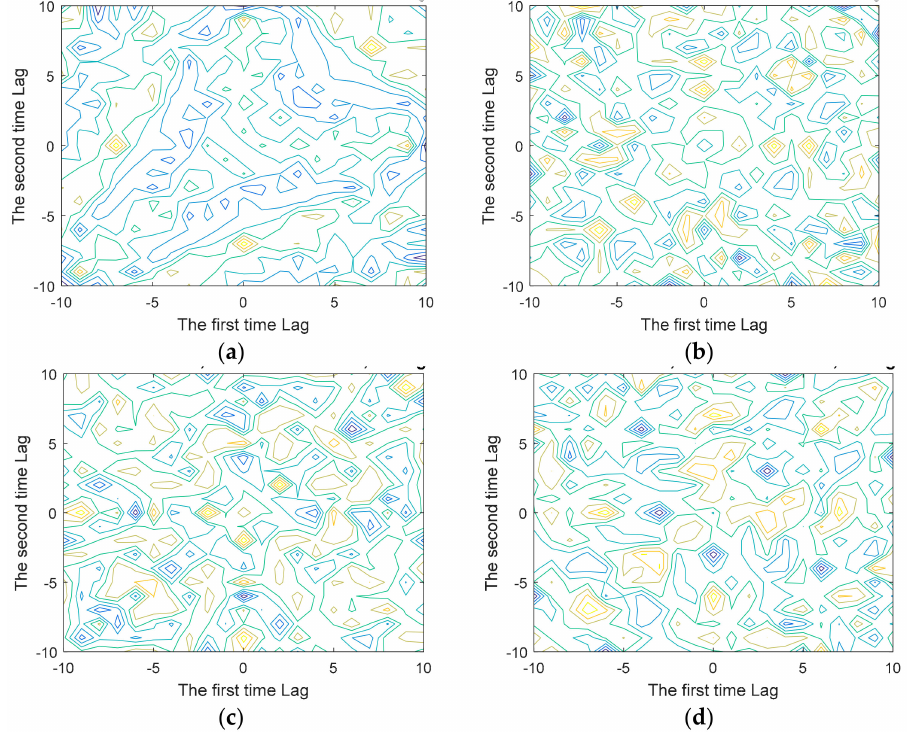
Figure 8. The 2D contour plot of third order cumulants ( a ) ‘HORSE’ (Sample 25); ( b ) ‘MONKEY’ (Sample 27); ( c ) ‘SNAKE’ (Sample 30); ( d ) ‘TIGER’ (Sample 31).